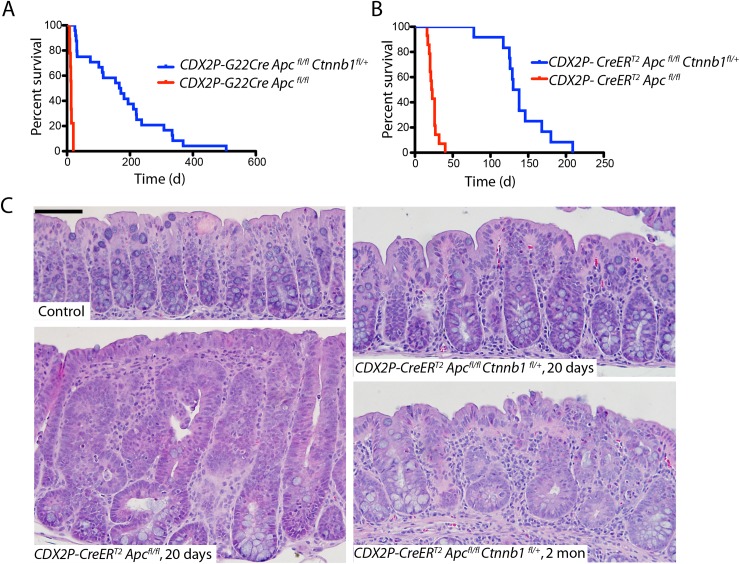

Apc mutation-induced polyposis in mouse cecum and colon epithelium is dramatically inhibited by concurrent inactivation of one Ctnnb1 allele.(A) The survival of CDX2P-G22Cre Apc
fl/fl
Ctnnb1
fl/+ mice (blue; n = 24) is contrasted with that of CDX2P-G22Cre Apc
fl/fl mice (red; n = 9). P <0.0001 by log-rank (Mantel-Cox) test. (B) The survival of CDX2P-CreER
T2
Apc
fl/fl
Ctnnb1
fl/+ mice (blue; n = 12) is contrasted with that in CDX2P-CreER
T2
Apc
fl/fl mice (red; n = 14), where time zero represents the third day of three days when TAM was administered daily. P <0.0001 by log-rank (Mantel-Cox) test. (C) Hematoxylin and eosin (H&E) staining of proximal colon tissues from a CDX2P-CreER
T2
Apc
fl/fl mouse 20 days after the third of three daily doses of TAM (left, lower), and a control (non-gene-targeted) mouse (left, upper). Right panels show H&E staining of proximal colon tissues from CDX2P-CreER
T2
Apc
fl/fl
Ctnnb1
fl/+ mice 20 days (right, upper) or 2 months (right, lower) after TAM dosing. Scale bars, 50 μm.